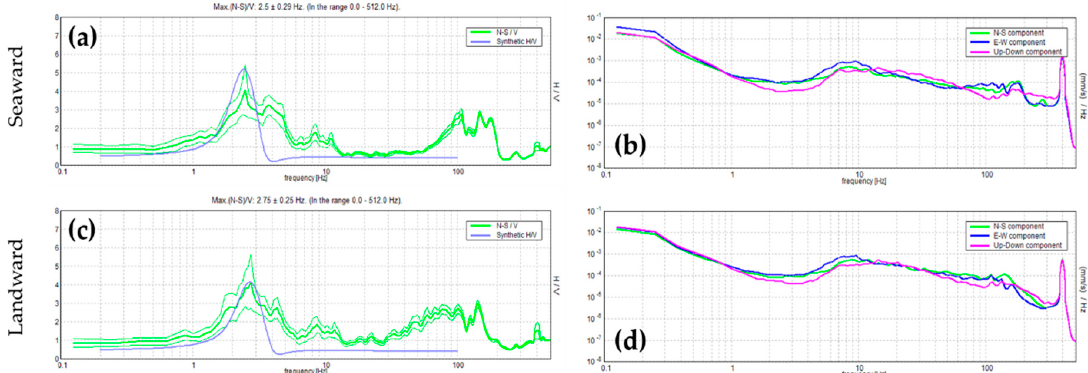
Figure 10. N-S/V spectral ratio, synthetic N-S/V and single component spectra at the seaward and landward side of the palisade; ( a ) measured (green lines, where thick line is the average and thin lines are the standard deviation) and synthetic (blue line) N-S/V spectral ratio at the seaward side; ( b ) directional components spectra at the seaward side; ( c ) measured (green) and synthetic (blue) N-S/V spectral ratio at the landward side; ( d ) directional components spectra at the landward side.